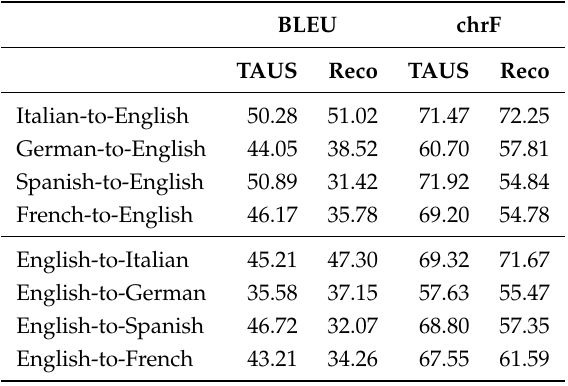
Table 2. Performance of the baseline NMT